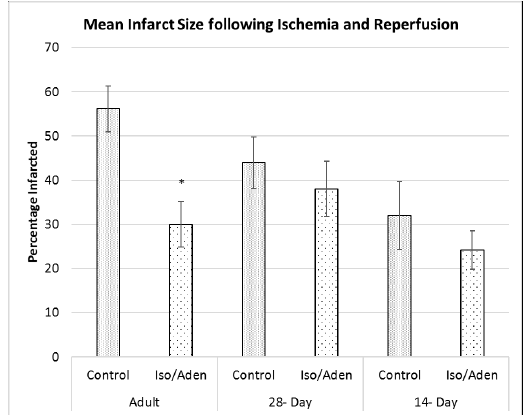
Figure 7. The effect of Iso/Aden on infarct size after 30 min ischemia and 2 h reperfusion. Infarct size in adult, young adult and immature hearts with or without pre-treatment with Iso/Aden. Data presented as mean ± standard error. * p < 0.05 vs. Control of the same age group.